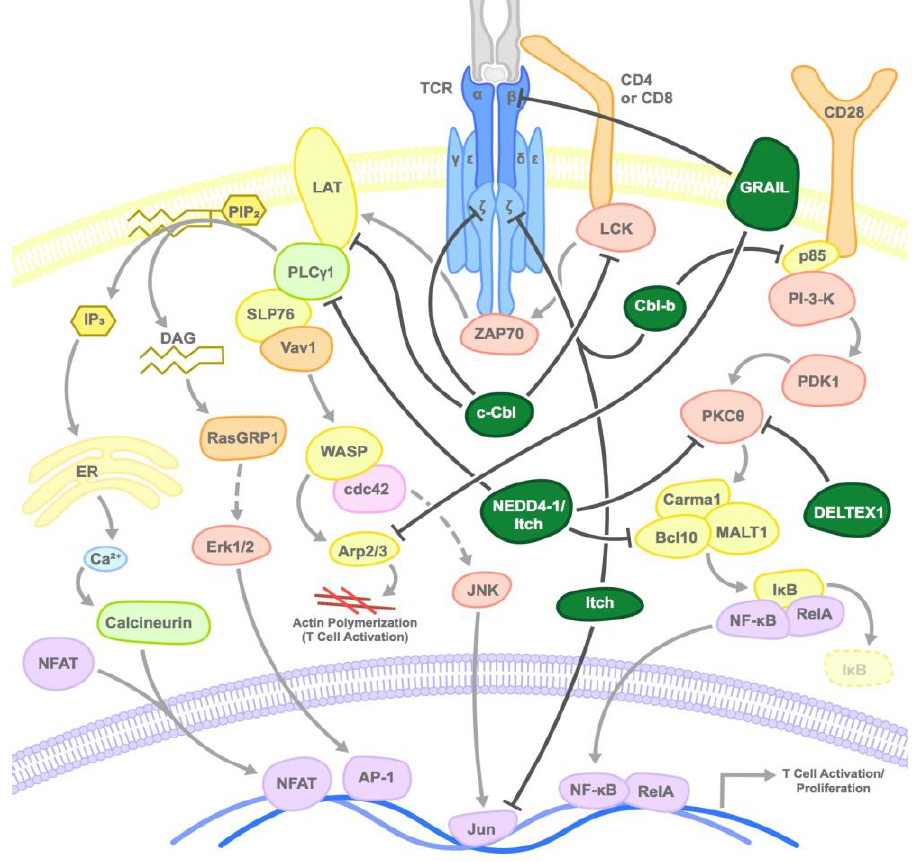
Figure 1. Mode of inhibition of T cell activation by E3 ubiquitin ligases: E3 ubiquitin ligases inhibit T cell receptor (TCR) activation at various steps by inducing the proteasomal degradation or sequestration of various substrates as shown. Dark green circles represent the E3 ligases and arrows point to primary target substrates.